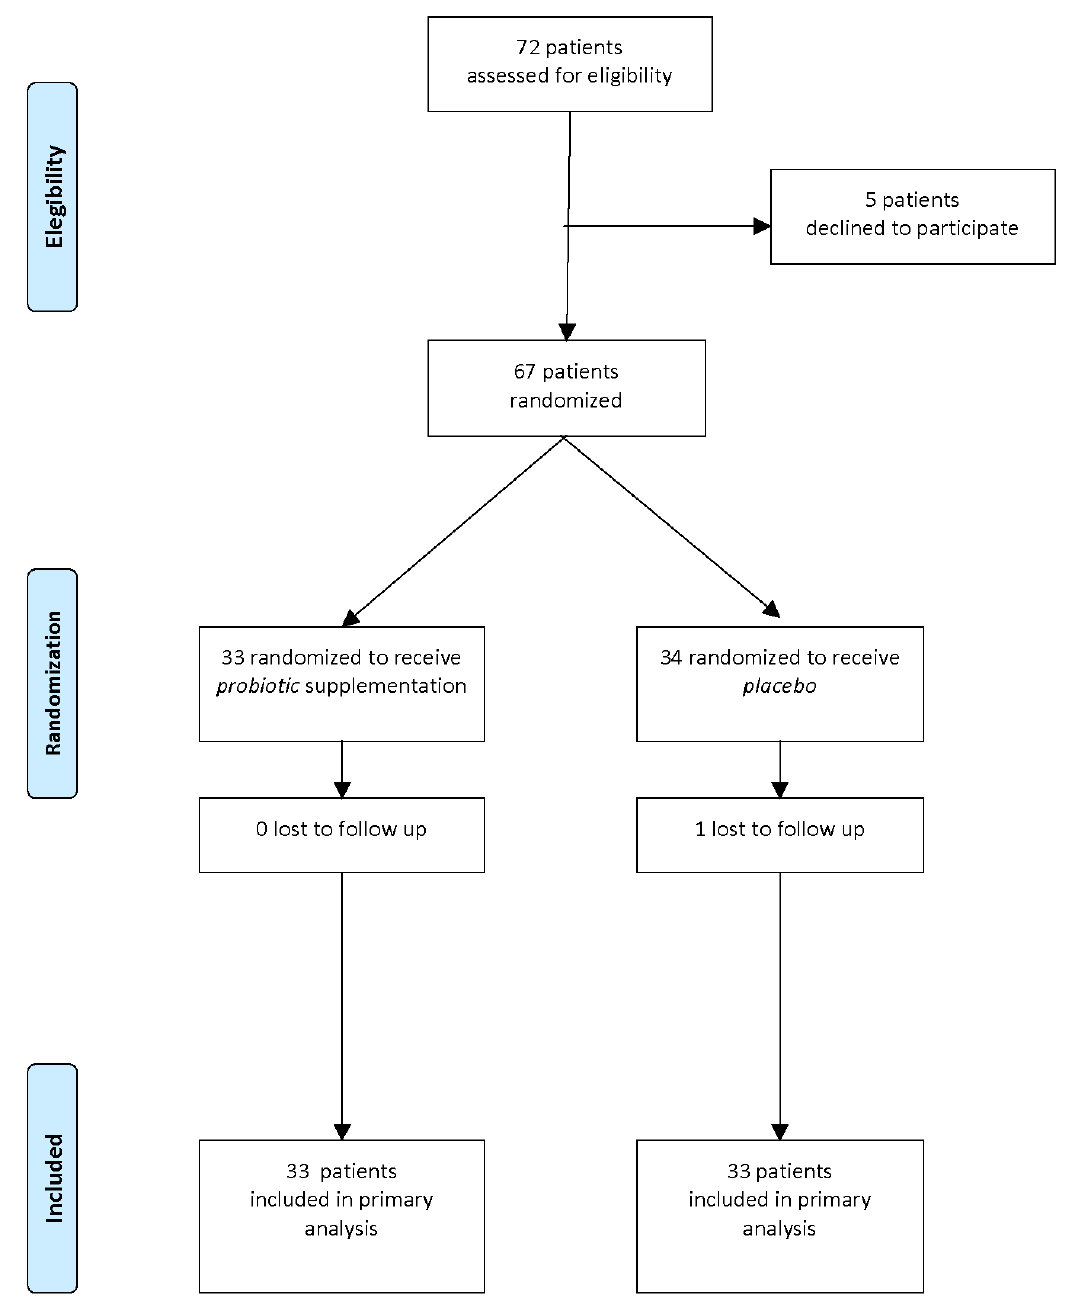
Figure 1. Study flow diagram.